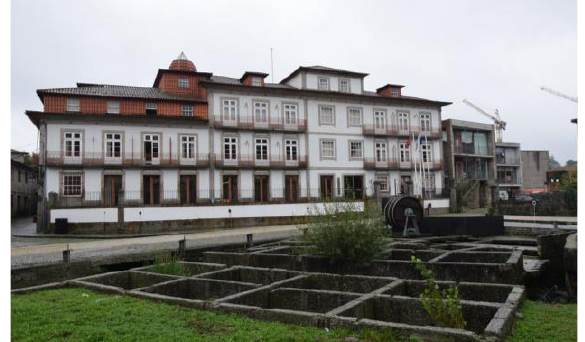
Figure 9. Main front views of Student